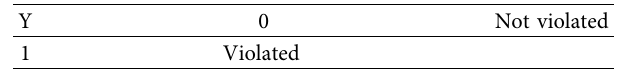
Table 16: Dependent variables.